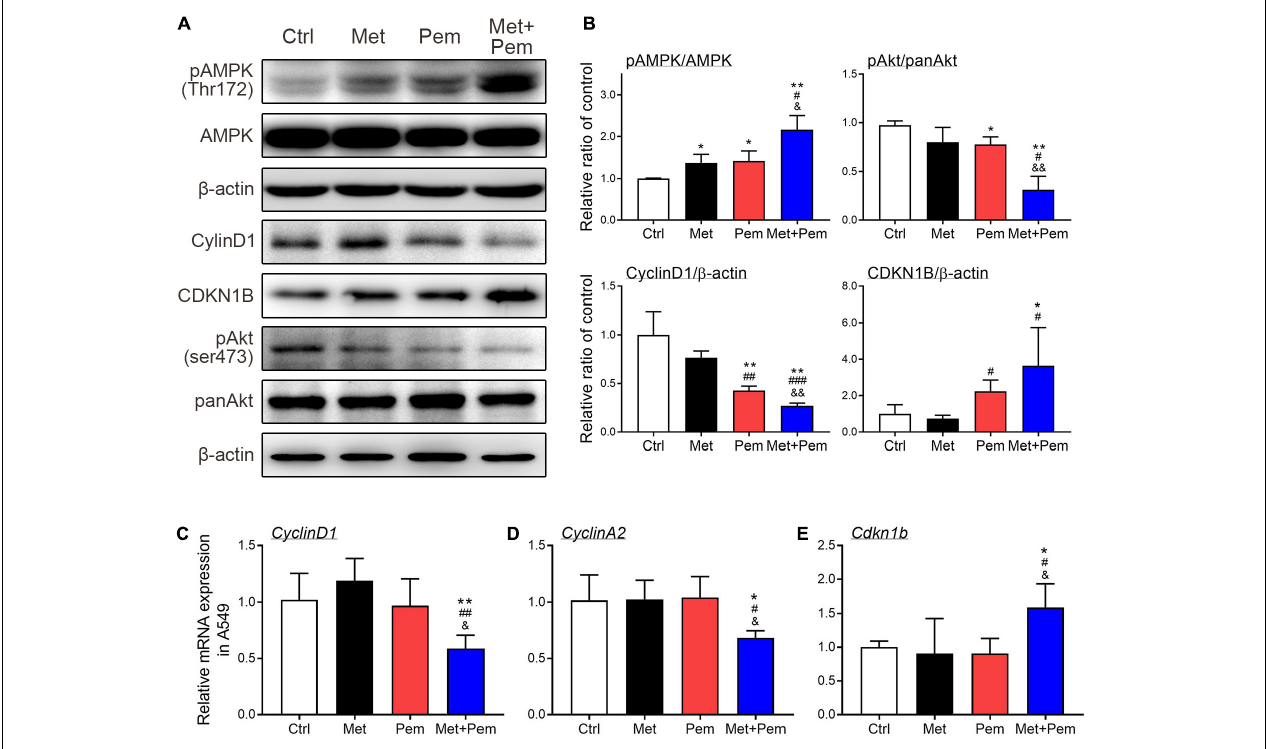
FIGURE 3 | Additive cell cycle arrest of metformin and pemetrexed on A549 cell line through modulating AMPK-AKT signaling. (A) Western blotting was performed to detect the expression of pAMPK/AMPK, pAKT/panAKT, cyclin D1 and CDKN1B in the A549 cell line. Human β -actin was used as the normalization control. (B) Values were normalized to human β -actin levels and expressed relative to the control. RT-qPCR was performed to analyze (C) cyclin D1, (D) cyclin A2, and (E) CDKN1B. Values were normalized to the β -actin gene and expressed in relation to the control. Data are presented as the mean ± SD of those from three independent experiments with two technical replicates in each. * P < 0.05 and ** P < 0.01 compared with the Ctrl group; # P < 0.05, ## P < 0.01 and ### P < 0.001 compared with the Met group; & P < 0.05 and && P < 0.01 compared with the Pem